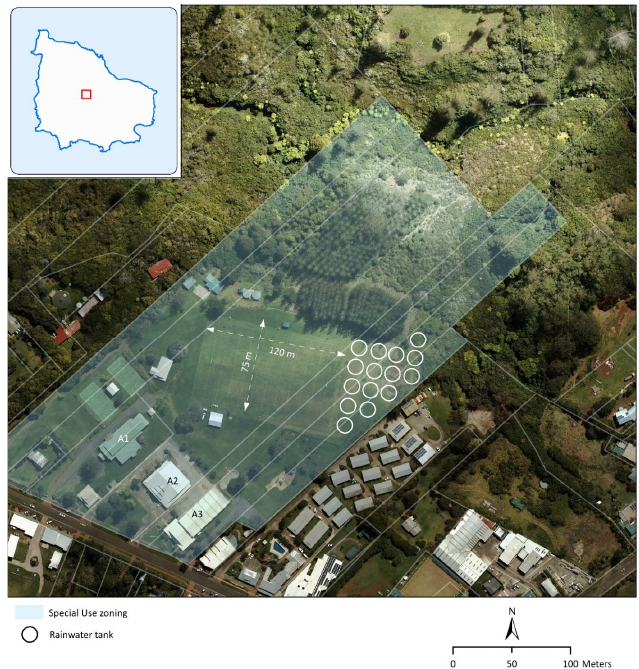
Figure 3. Aerial view of configuration of cluster-scale RHRWS centred around the Bicentennial Oval. Building ID A1, A2 and A3 correspond to Table 2.